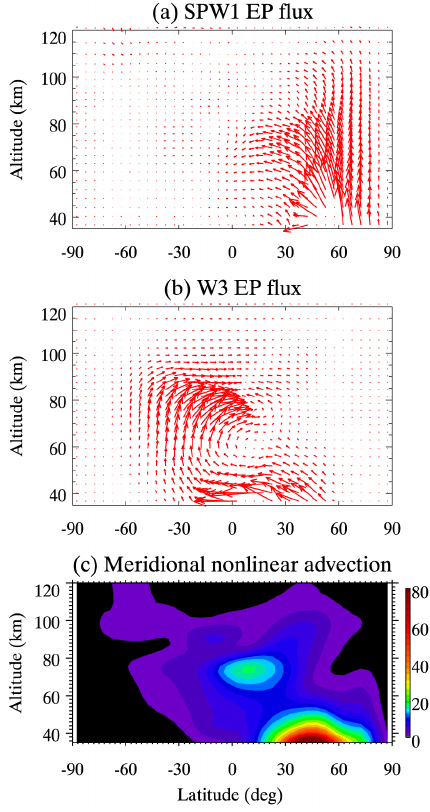
Figure 13. The EP flux vectors of (a) the SPW1 and (b) the W3 during model days 15–20 of case 3. (c) The amplitude (ms − 12 ) of the meridional component of the nonlinear advection tendency between W3 and